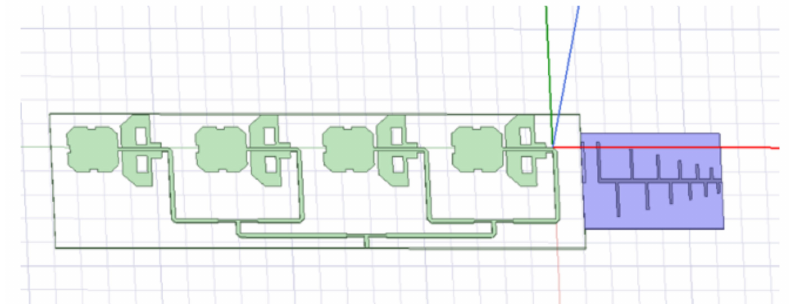
Figure 7. Transceiver antenna model.